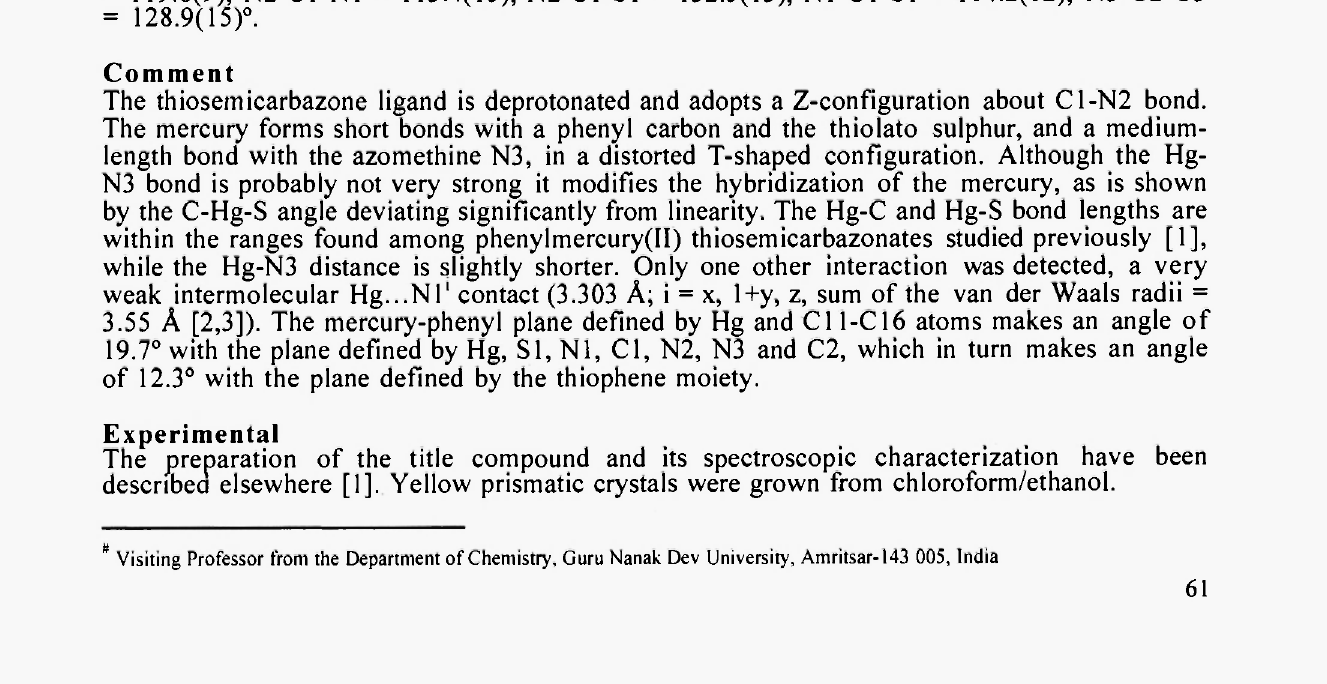
Figure 1. ORTEP plot of [HgPh(tftsc)] at the 50% probability level. Selected bond distances and angles: Hg-Cll = 2.067(15), Hg-Sl = 2.380(4), Hg-N3 = 2.475(13), Sl-Cl = 1.729(17), Nl-Cl = 1.392(19), N2-C1 = 1.356(19), N2-N3 = 1.398(16), N3-C2 = 1.337(19), C2-C3 = 1.45(2) Ä, CI 1-Hg-Sl = 168.1(4), Cll-Hg-N3 = 115.9(5), Sl-Hg-N3 = 76.0(3), Cl-Sl-Hg = 101.4(5), C1-N2-N3 = 109.4(13), C2-N3-N2 = 111.0(13), C2-N3-Hg = 127.7(11), N2-N3-Hg = 119.8(9), N2-C1-N1 = 113.4(15), N2-C1-S1 = 132.5(13), N1-C1-S1 = 114.2(12), N3-C2-C3 =